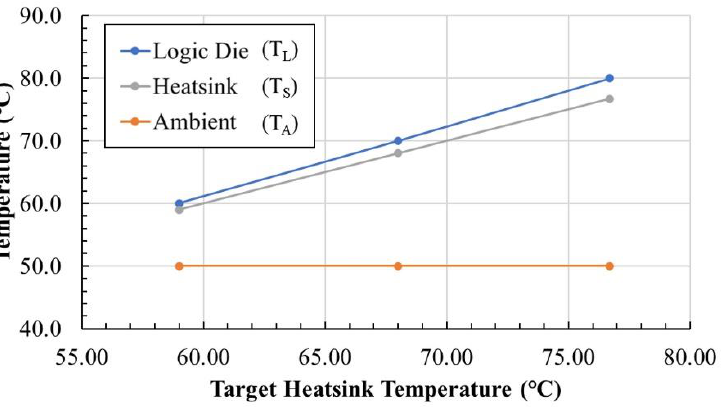
Figure 9. Base logic-die temperature (T L ) is controlled by the heatsink temperature (Ts), which is controlled with PWM values by the microcontroller.